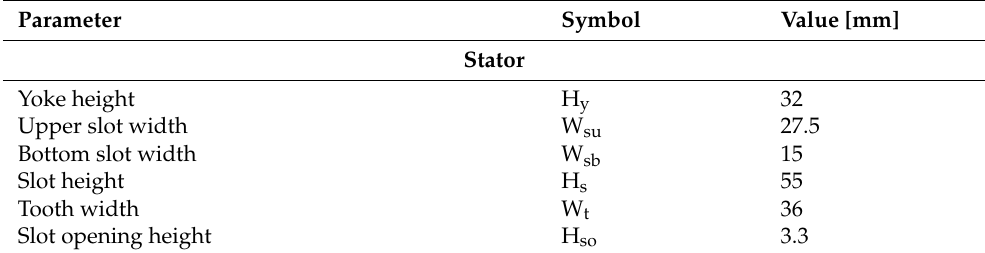
Table 5. Machine dimensions of the proposed 6Φ -SS-FSCW-Fer-SIPMSM.